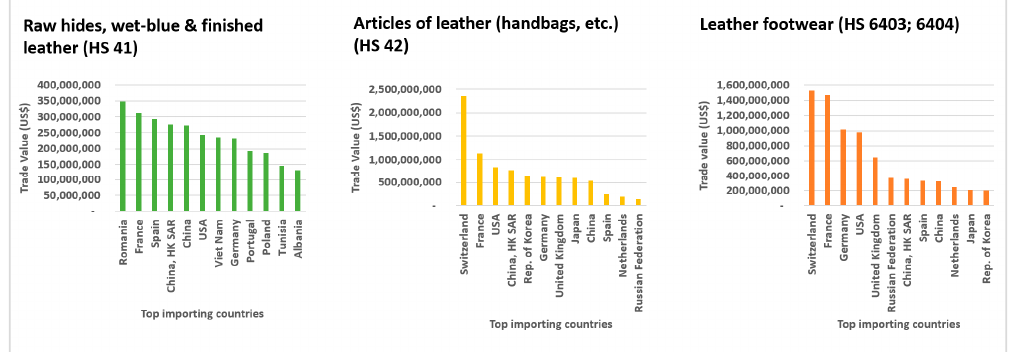
Figure 5. Top 12 country importers of Italian exports of leather (raw, semi-processed and finished combined HS41), articles of leather (HS 42) and leather footwear (HS 6403;6404) in 2018, in trade value USD [25].